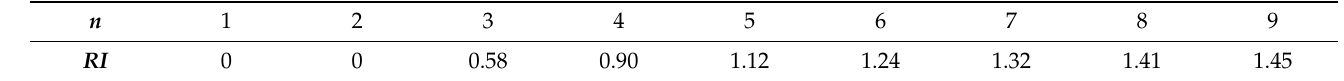
Table 3. Saaty’s random index for different values of the number of criteria